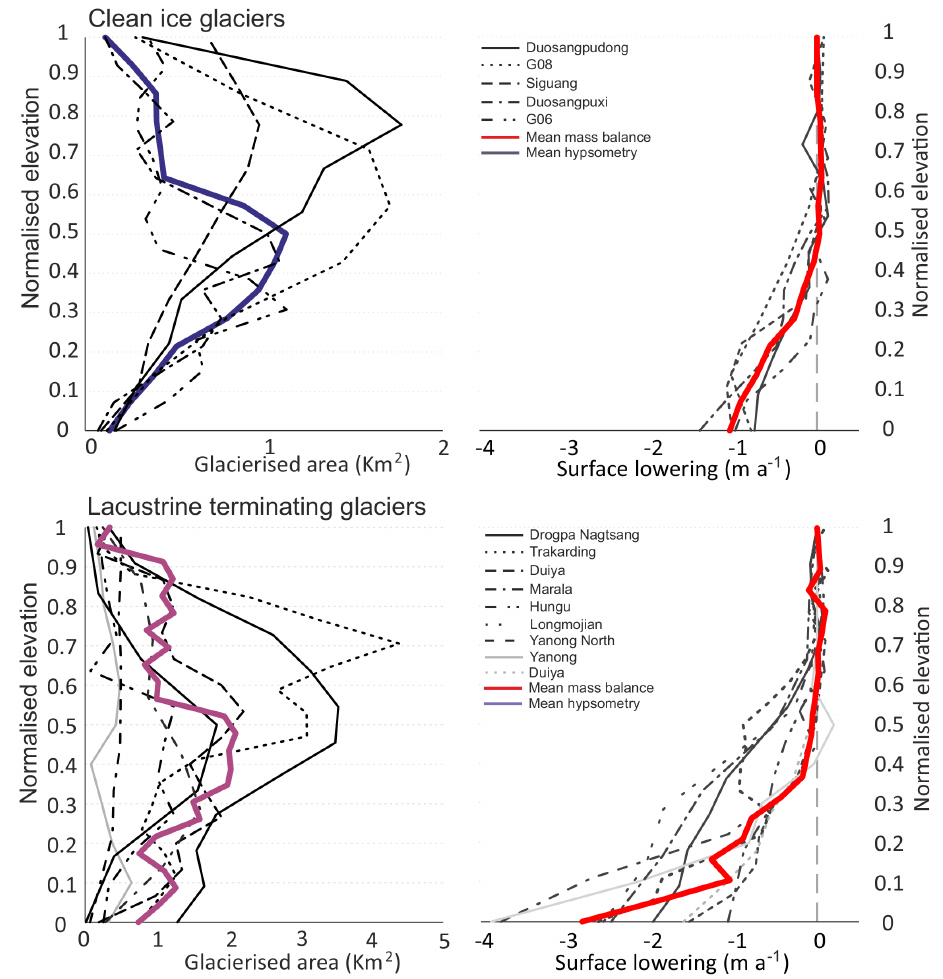
Figure 6. Surface-lowering and glacier hypsometry curves for clean ice and lacustrine-terminating glaciers in the study area.